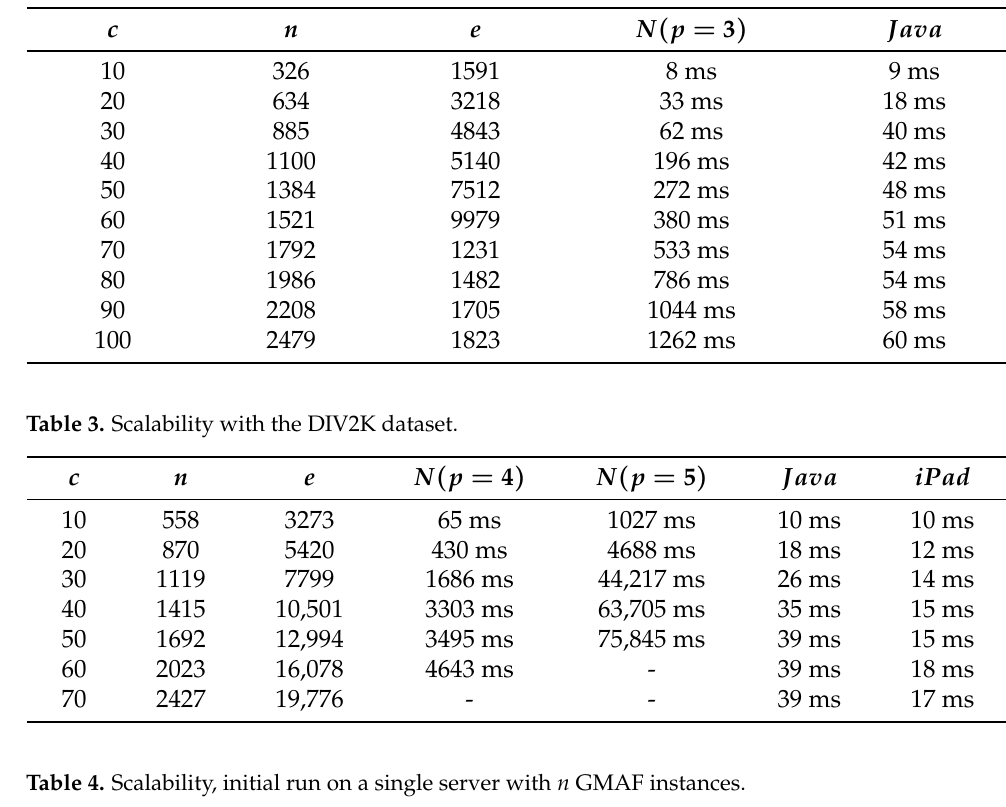
Table 2. Scalability with the Flickr30K dataset.